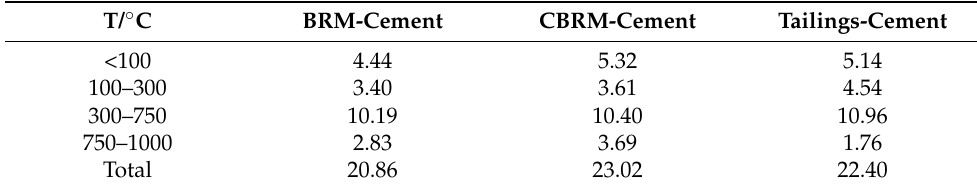
Table 6. The mass loss of BRM-cement, CBRM-cement, and Tailings-cement (wt%). T/ ◦ C